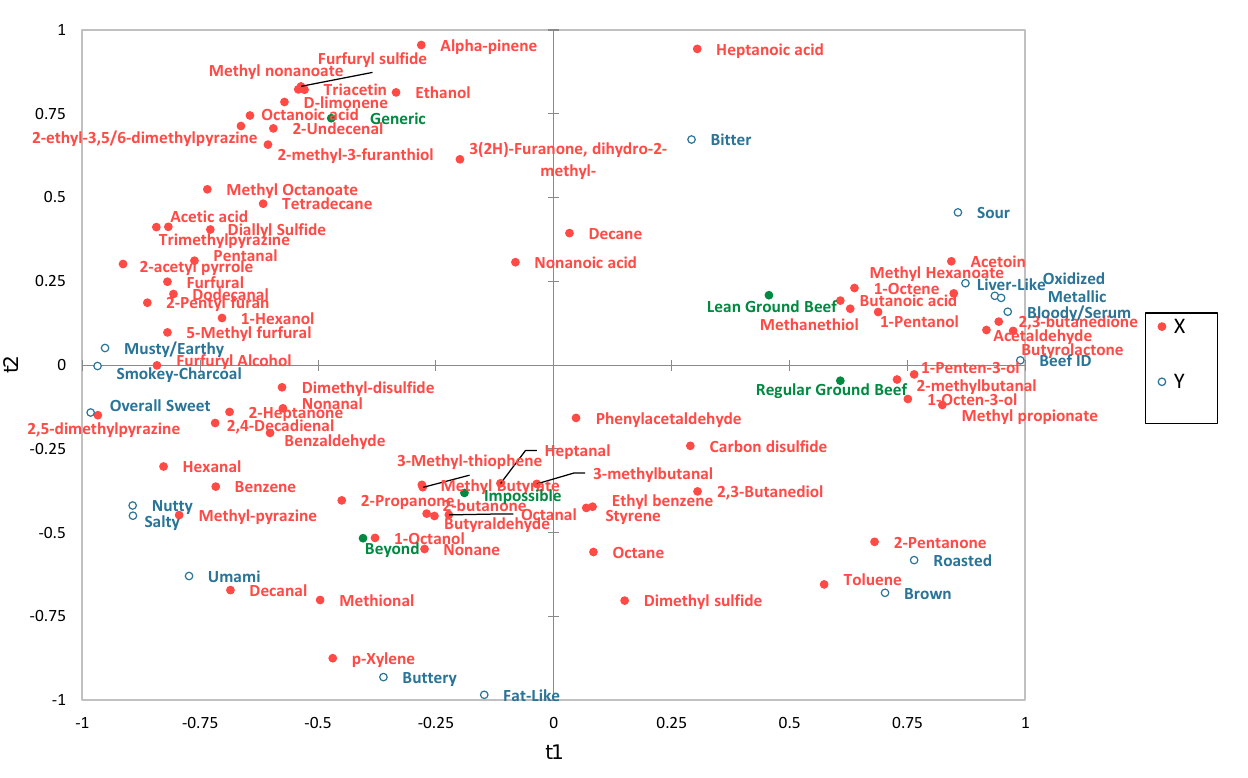
Figure 2. Partial least squares regression bi-plot of ground beef and plant-based meat alternatives where descriptive flavor attribute served was the dependent variable and quantitated volatile com- pound concentration (ng/g) served as the explanatory variable.